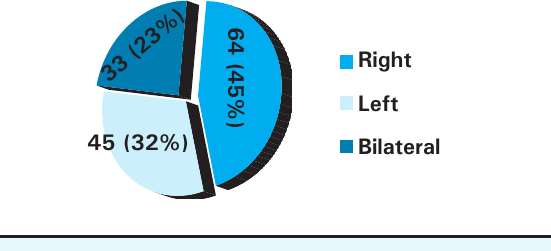
Figure 1. side of bleeding. Past history of bleeding was given by 79 (55.6%) patients and out of them 60 (75.9%) had bleeding from same side. Twenty five patients give history of nasal trauma in past (more than 1 month back).History of alcohol intake within 48 hours of onset of bleeding was given by 45 (31.7%) patients. Presentation was mostly in months of January to March (Figure 2).